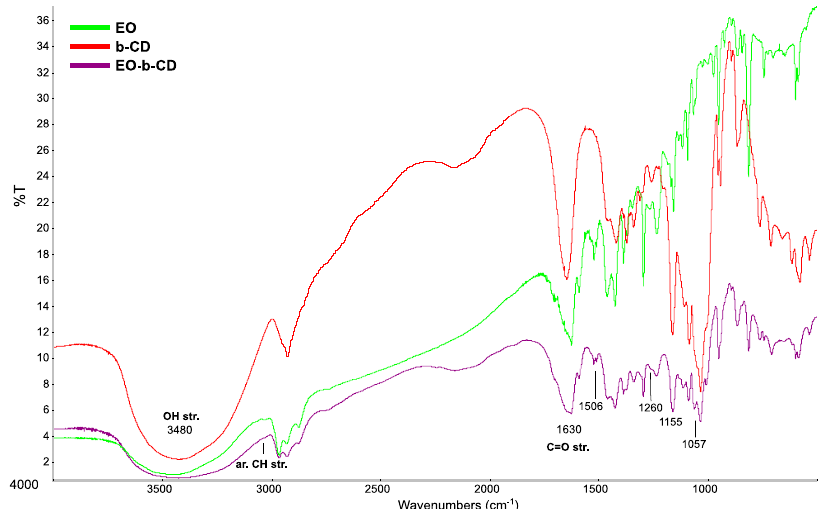
Figure 1. FT-IR spectra of essential oil (green), cyclodextrin (b-CD) (red), and EO-b-CD (purple).